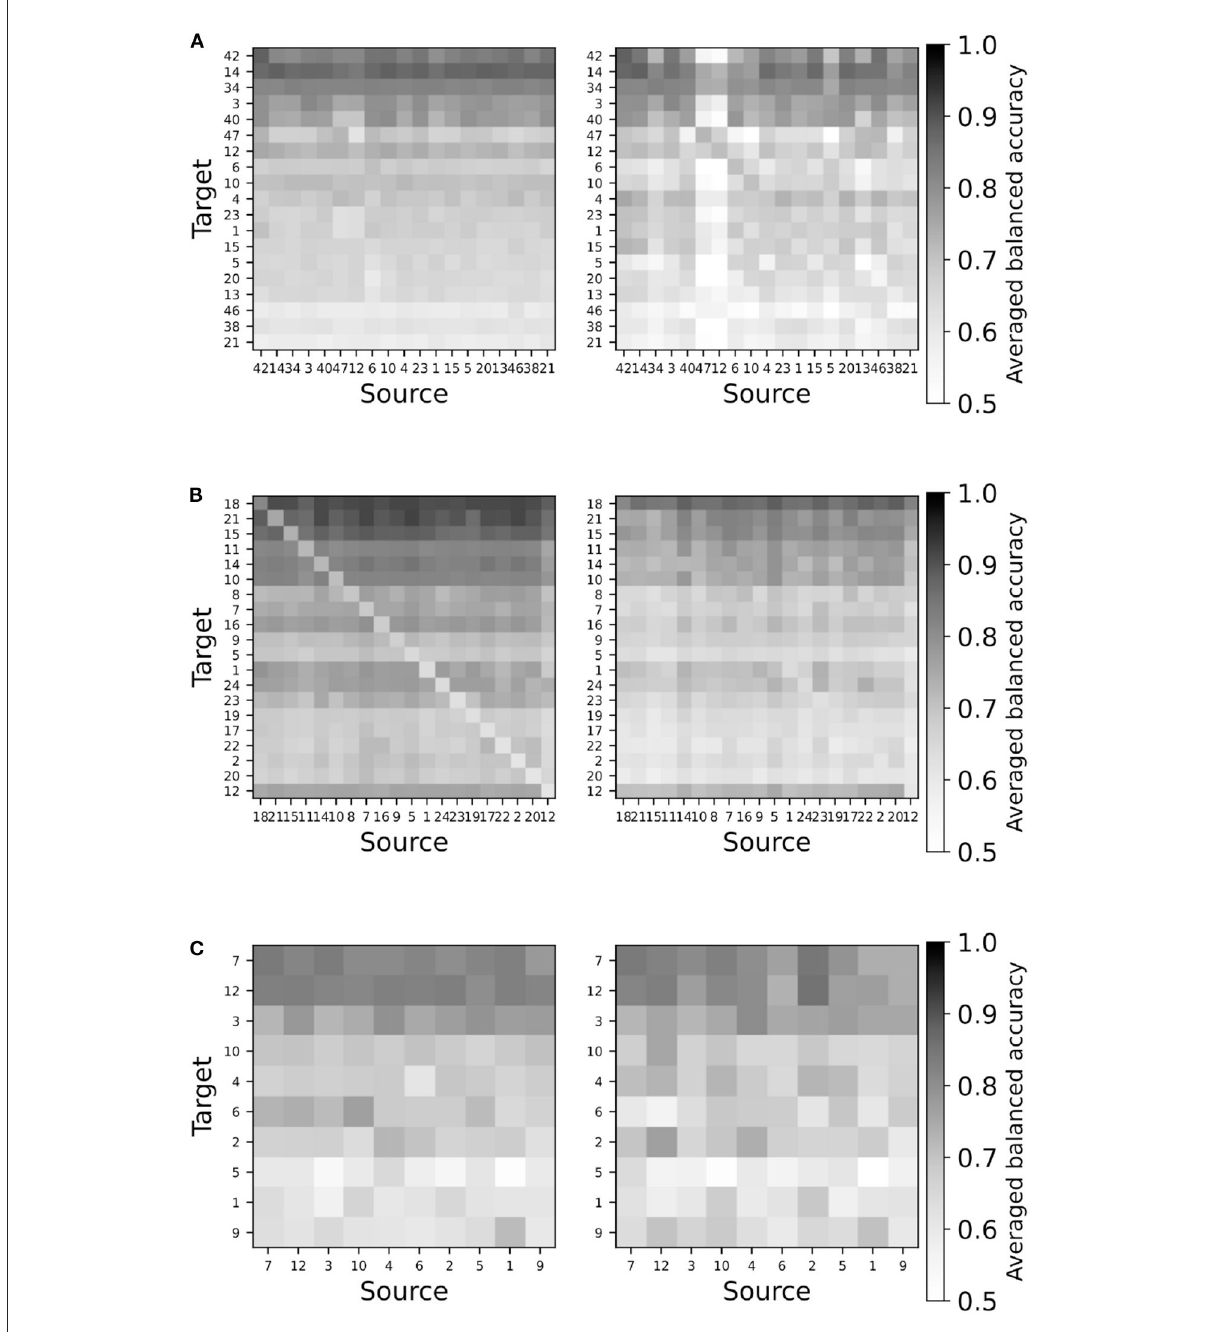
FIGURE3 Representative seriation plots for TSA (left) and RPA (right) methods for each paradigms. See text for details. (A) Database Cho2017 (MI). (B) Database brain invaders 2013a (ERP). (C) Database SSVEP exoskeleton (SSVEP).